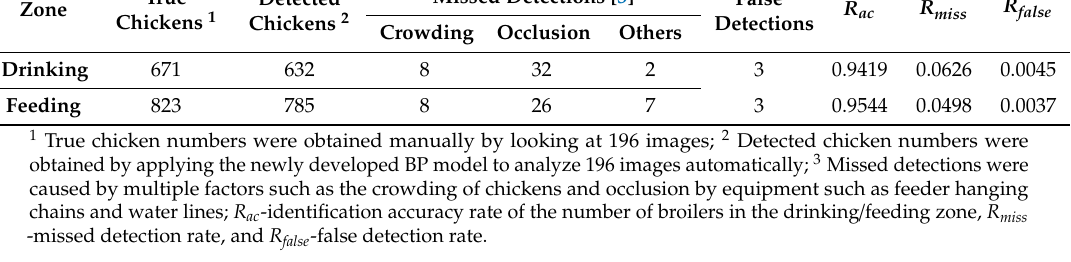
Table 2. Test of the BP model on 196 images on identification of chicken distribution in the feeding/drinking zones.